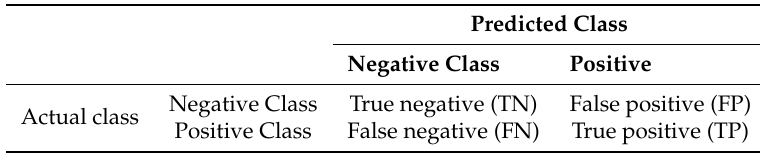
Table 4. Confusion